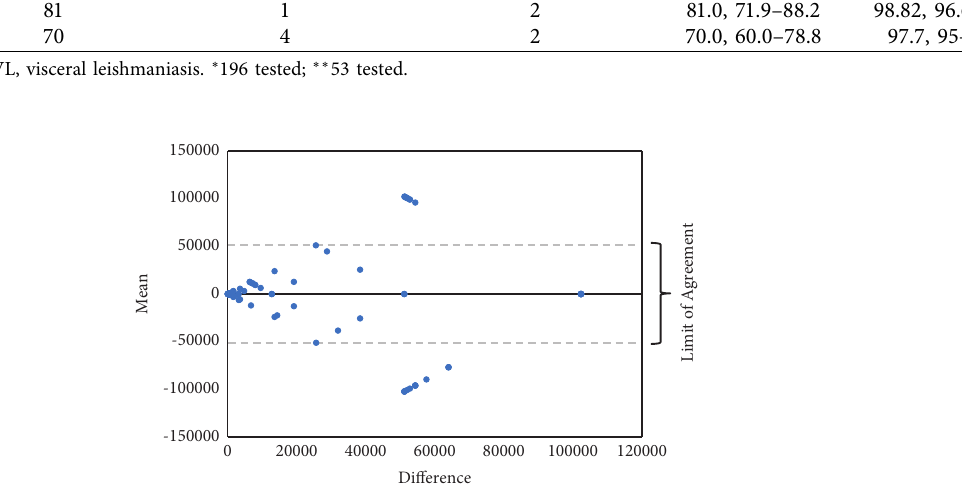
Figure 1: B&A graph of differences between titers in DAT-KITand DAT-ITM versus the mean of the two titers. The solid line represents the mean difference and the two dotted lines represent the lower and upper limits of agreement. Table 2: Kappa values expressing agreement between the sero- logical